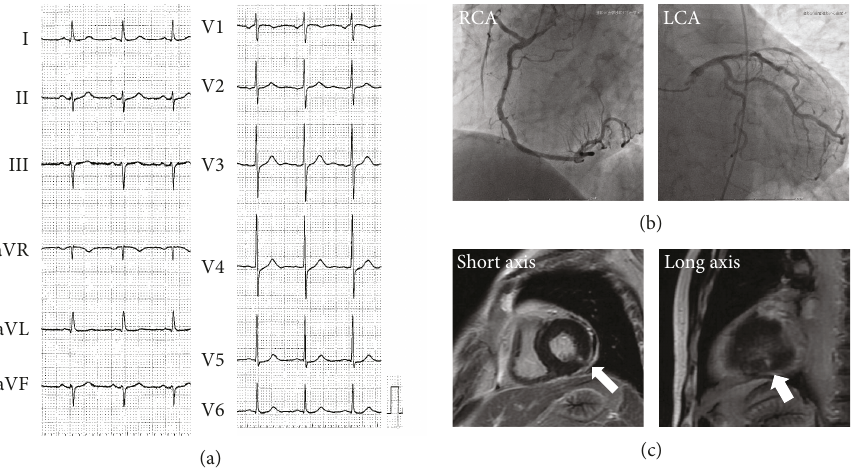
Figure 1: Electrocardiography (ECG), coronary angiography (CAG), and cardiac magnetic resonance imaging (C-MRI) on the fi rst admission. (a) ECG on admission revealed no signi fi cant change except a left axis deviation. (b) CAG revealed no coronary artery occlusion either in the right coronary artery (RCA: left anterior oblique 50 ° view) or the left coronary arteries (LCA: caudal 30 ° view). (c) C-MRI of short and long axis view. The arrows indicate the delayed enhancement of the